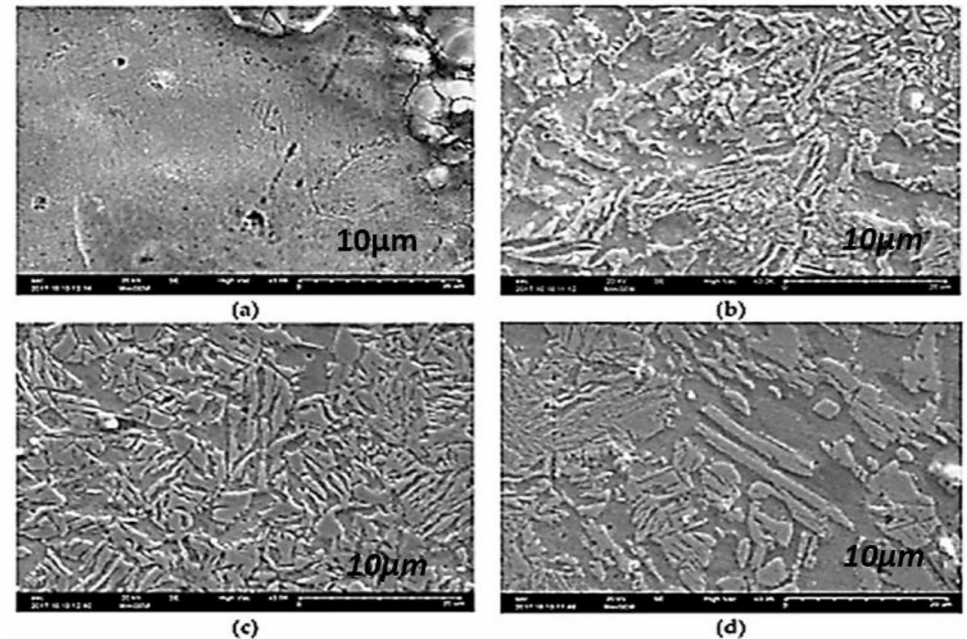
Figure 20. The morphological structures of austempered specimens at varying temperatures: